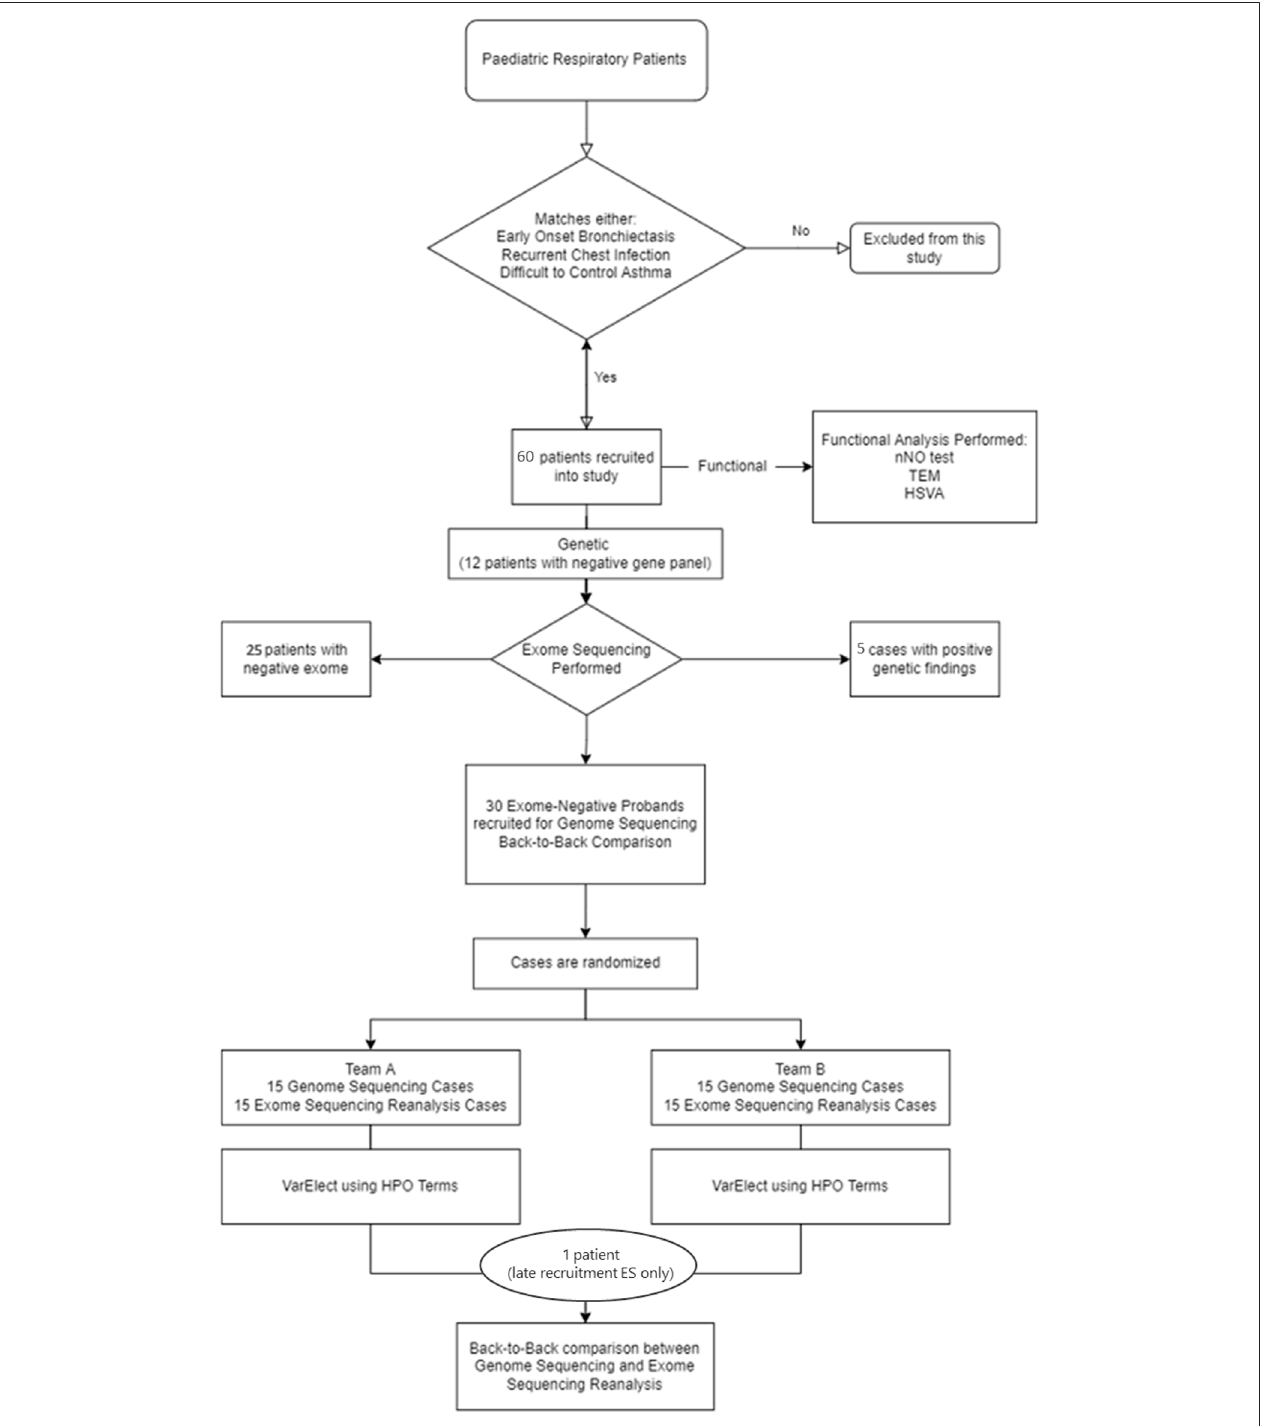
FIGURE 1 | Diagnostic work fl ow. The diagram shows this study design and work fl ow. In phase 1, 61 patients were recruited into the study for genetic and functionalanalysis. Inphase 2, 30exome-negativeprobandswererecruitedforGS and rESback-to-back comparison analysis.HSVM = high-speed videomicroscopy; HPO = human phenotype ontology; nNO test = nasal NO test; TEM = transmission electron microscopy.